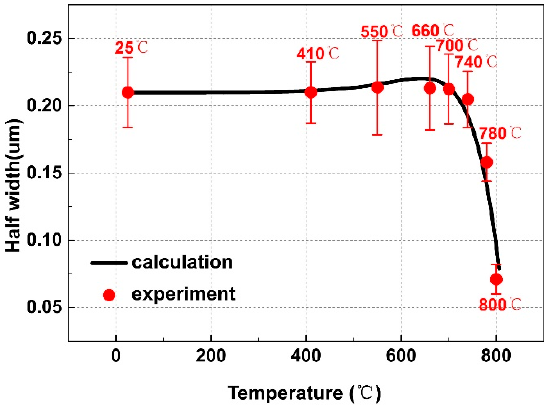
Figure 6. Calculated kinetic curves describe negligible growth and remarkable re-dissolution of α lath. The calculation results are compared with average half-width of lath α phase in the experiment.